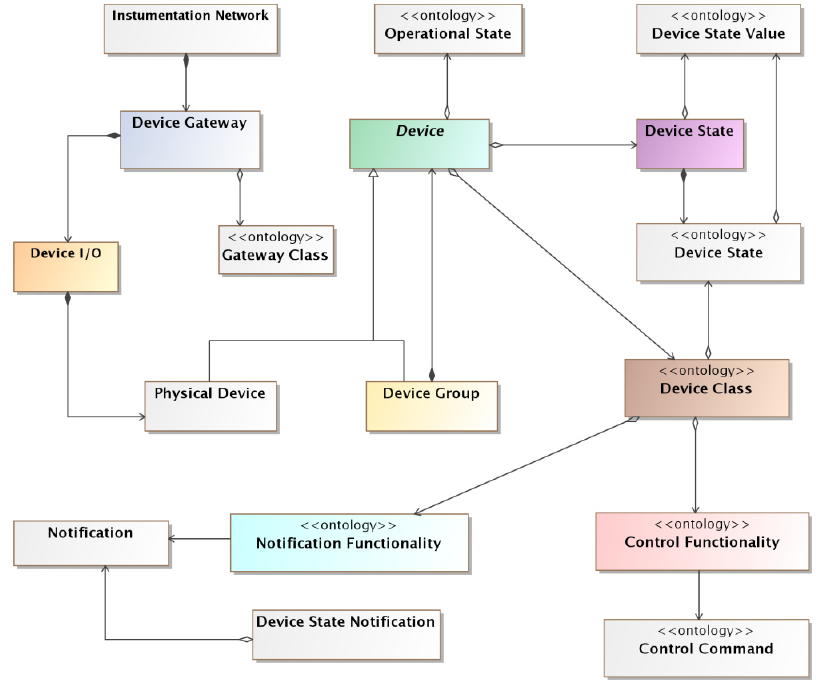
Figure 2. Simplified vision of the proposed conceptual model for instrumentation